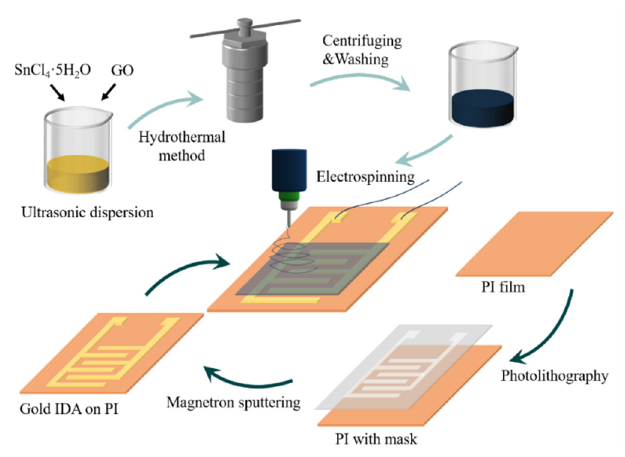
Figure 1. Schematic diagram of SnO 2 /rGO humidity sensor preparation process.